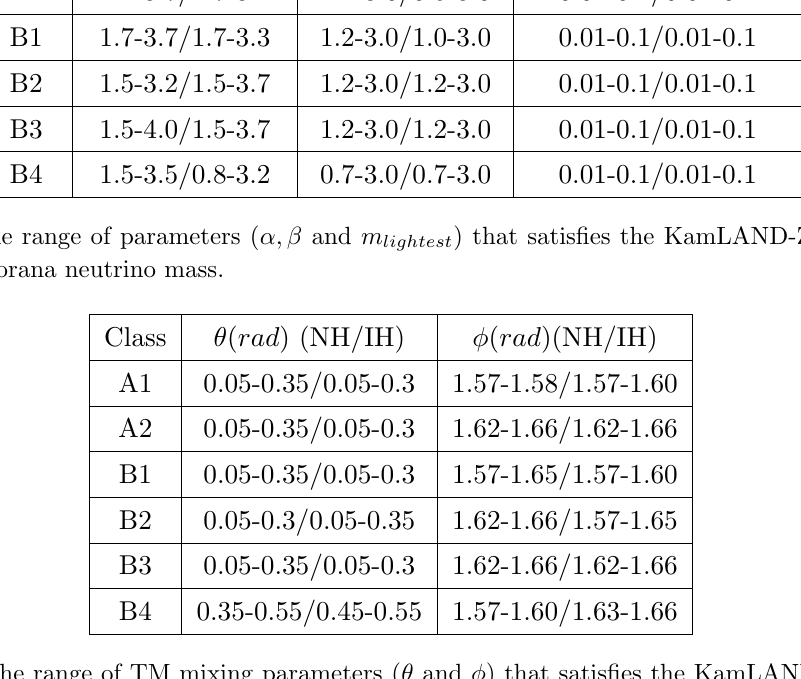
Table 10 . The range of TM mixing parameters ( (cid:18) and (cid:30) ) that satis(cid:12)es the KamLAND-Zen limit of e(cid:11)ective Majorana neutrino